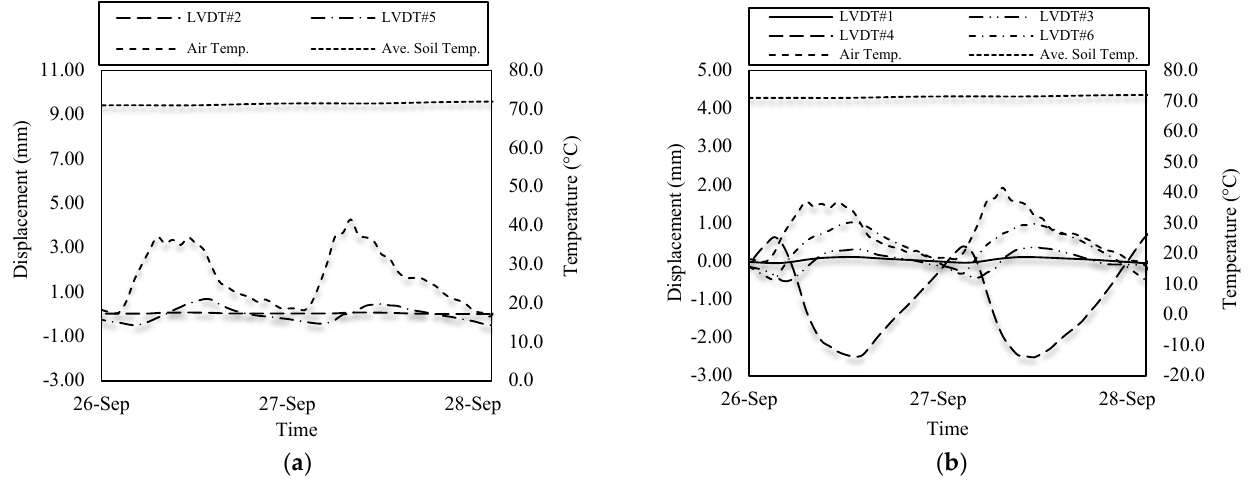
Figure 8. Measured temperatures and displacements ( a ) warm weather lateral displacement ( b ) warm weather longitudinal displacement. The reason LVDT #2 and #5 have opposite directions is because the LVDTs are ori- ented in opposite directions. LVDT #2 and #5 are measuring the lateral relative displace- ments between the end diaphragm and the wing walls on the obtuse and acute corners,